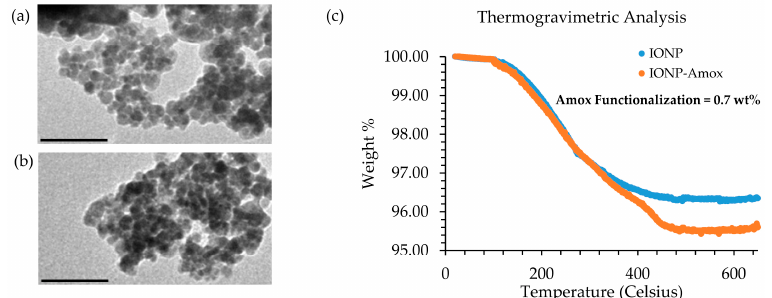
Figure 3. TEM images of: ( a ) IONP-Amox (scale bar = 100 nm), ( b ) IONP (scale bar = 100 nm), and ( c ) TG analysis data for IONP & IONP-Amox data.